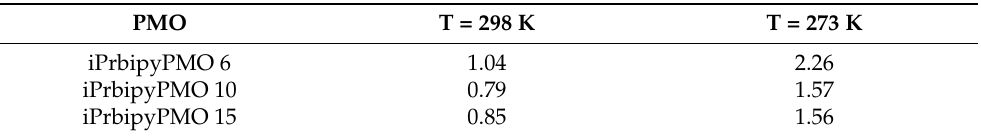
Table 4. Size distribution, standard deviation values of iPrbipyPMO NPs, analyzed from TEM, spe-